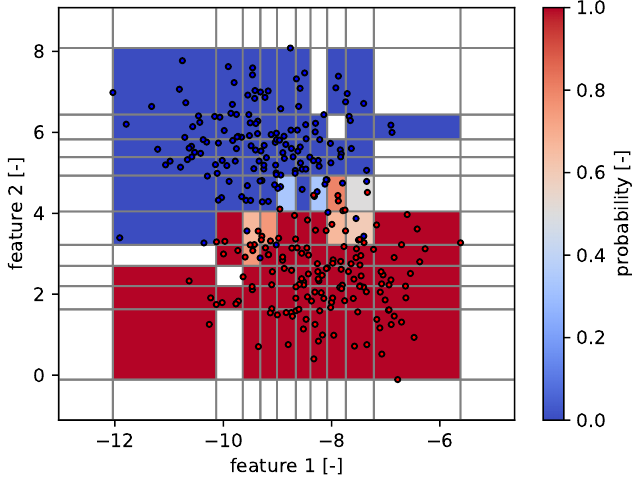
Figure 1. The derivation of classification probability for two clearly separable classes. The gray grid denotes the 0%, 10%, 20%, 30%, ..., 90%, 100% percentiles for each feature.